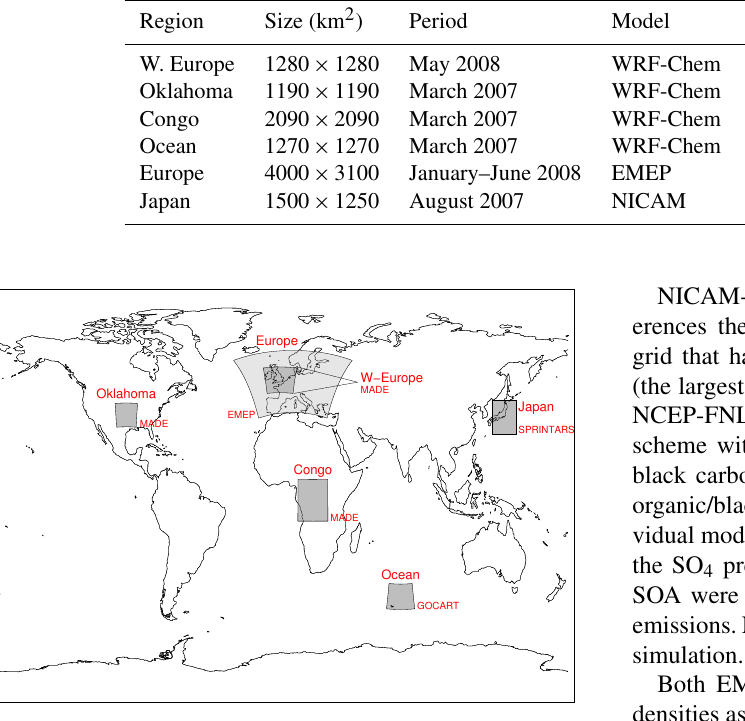
and SOA (secondary organic